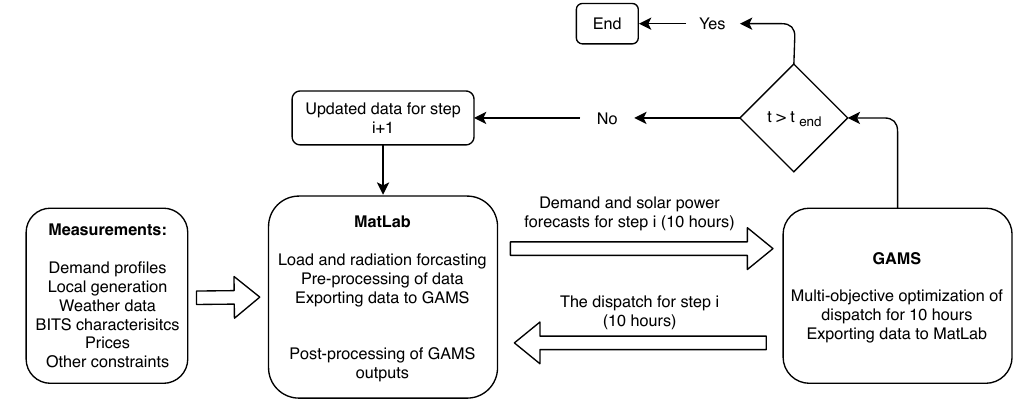
Figure 1. Flow chart of the dispatch model